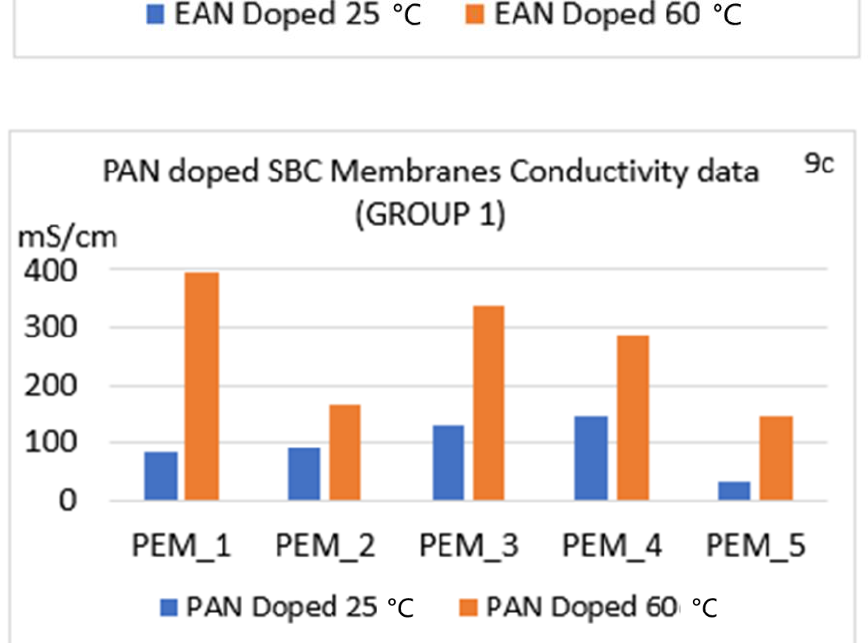
Figure 9. Comparison of conductivity values for nonannealed and annealed SBC membranes for all conditions for Group 1 membranes: PEM_1–PEM_5 (undoped and doped). ( a ) Undoped ( b ) EAN doped ( c ) PAN doped